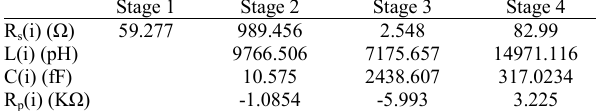
Table 2: RLC parameters for the spice circuit with